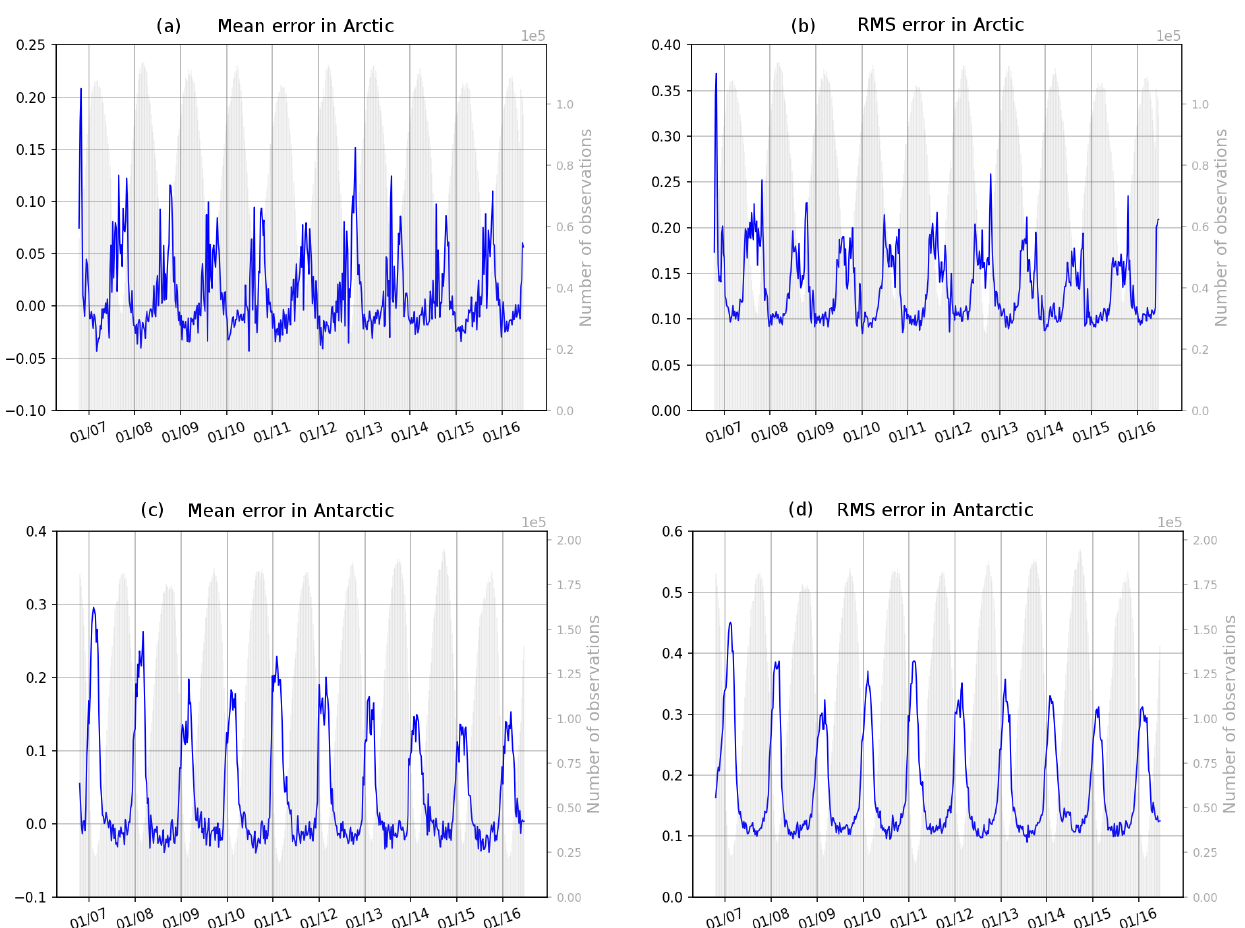
Figure 25. Sea surface height RMS difference between tide gauge observations and the system PSY4V3 for the year 2015. Unit is centimeters.